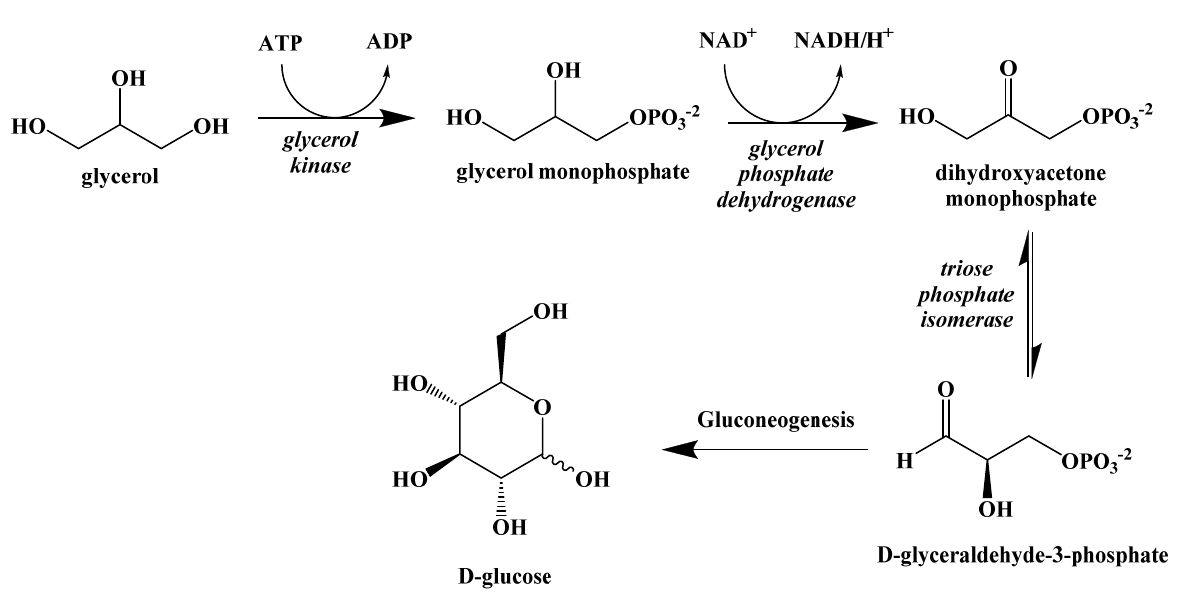
Figure 10. Metabolic Conversion of Glycerol to Glucose.